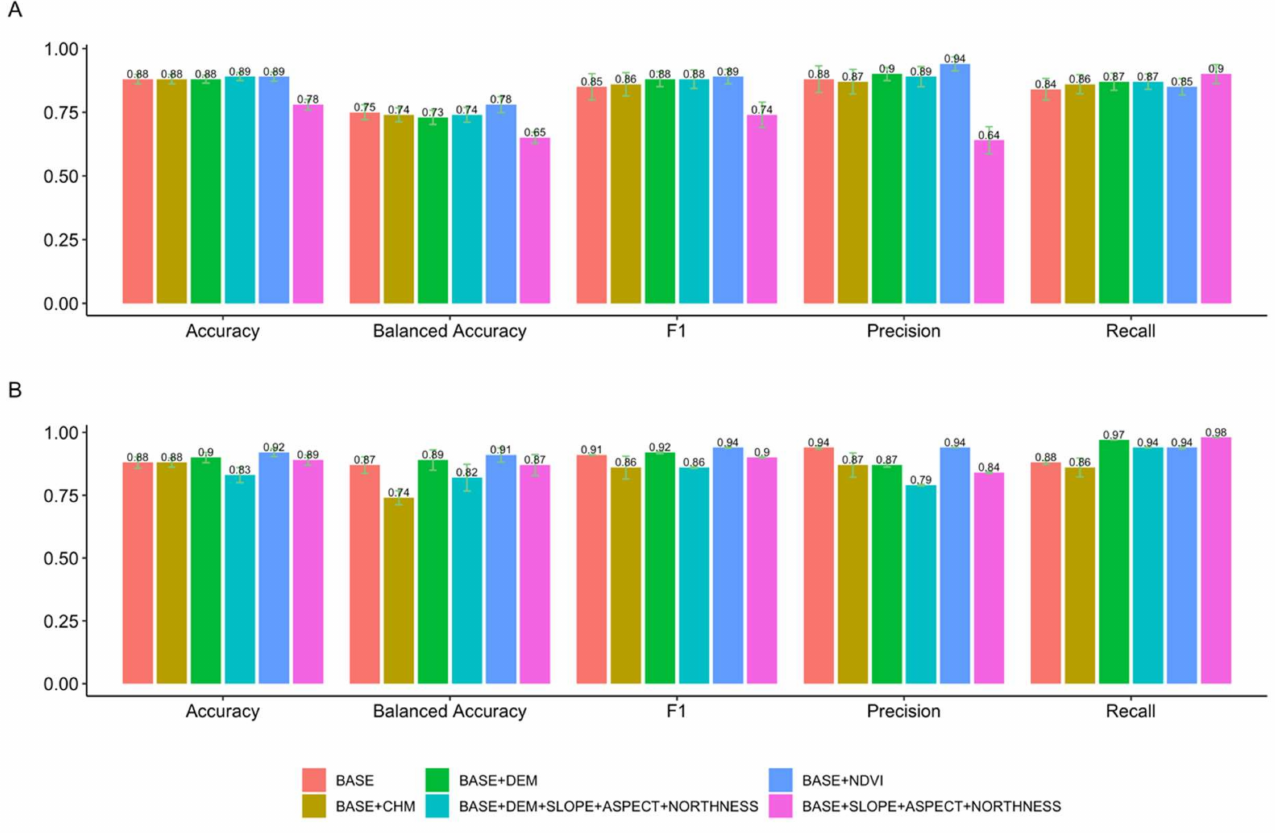
Figure 6. Detailed performance metrics of all the models at both the evaluation sites. ( A ) Complete metrics for Gunnison River basin, CO, USA. ( B ) Complete metrics for Engadin, Switzerland. Bars show standard deviation.